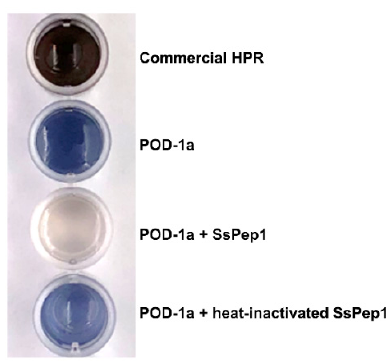
Figure 7. SsPEP1 potently inhibited sugarcane peroxidase activity. The substrates contained dia-